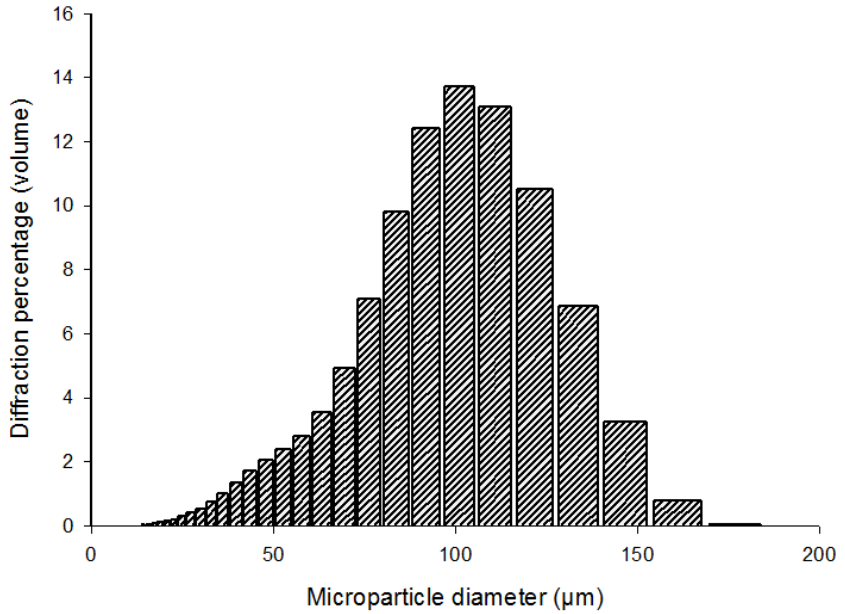
Figure 1. Size distribution (by volume) of protein loaded PLGA microparticles